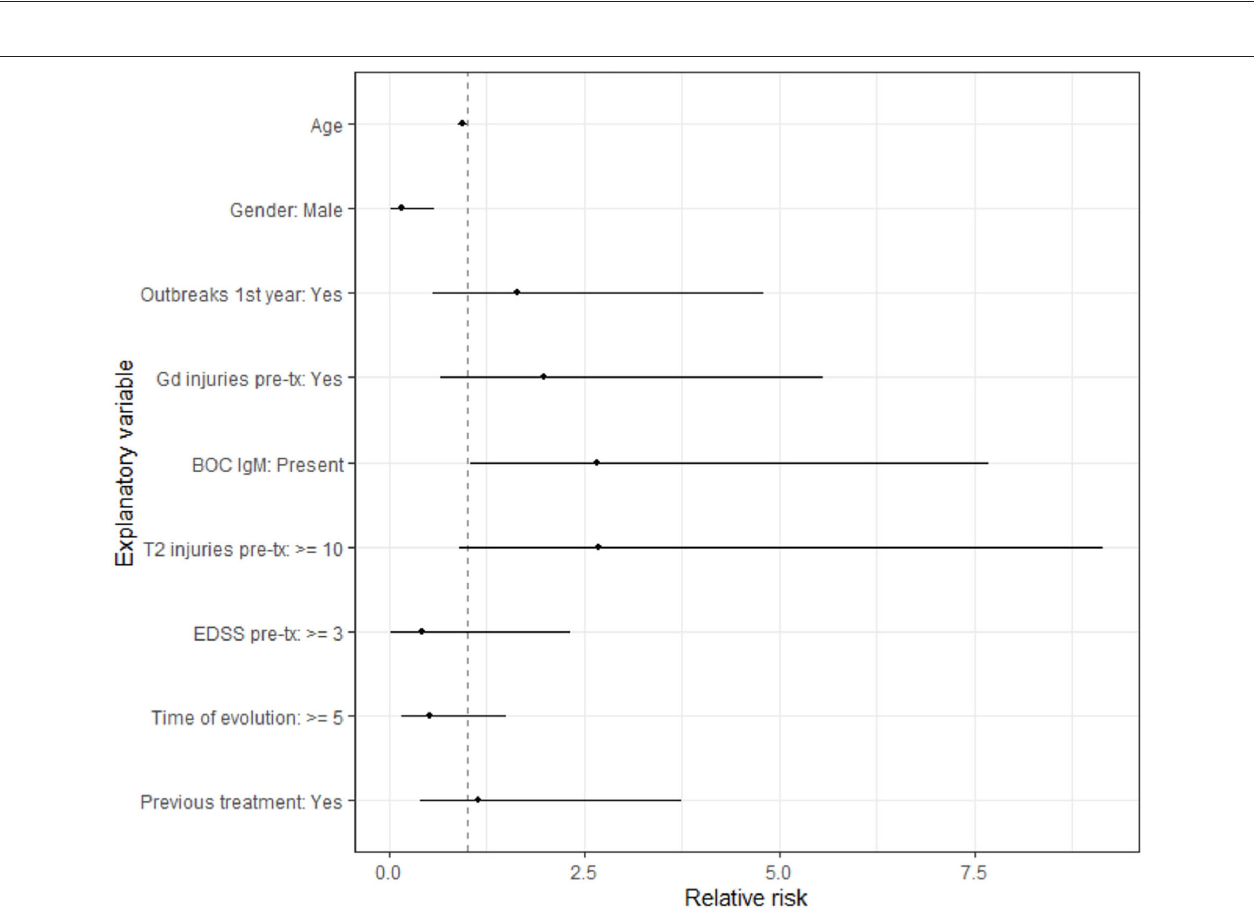
FIGURE 4 | Evolution of the number of the RM gadolinium + lesions. BOX, Interquartile range; Groos line, medias; Dots, Extrem values ( > 1.5 × interquartile range) disability.